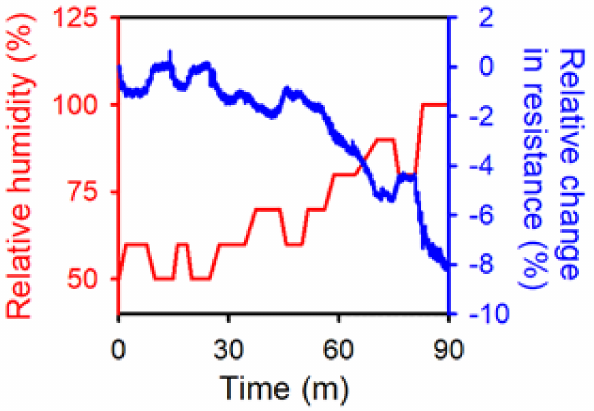
Figure 4. Relative change in resistance (blue) according to relative humidity level